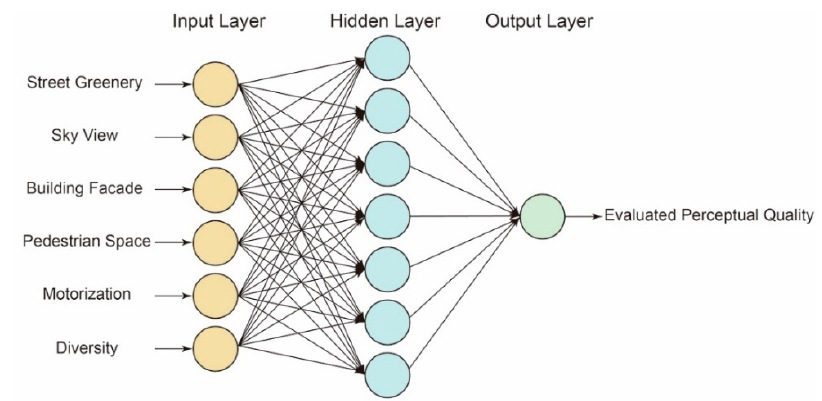
Figure 9. Artificial neural networks (ANN) implementation of the analysis of key spatial elements.